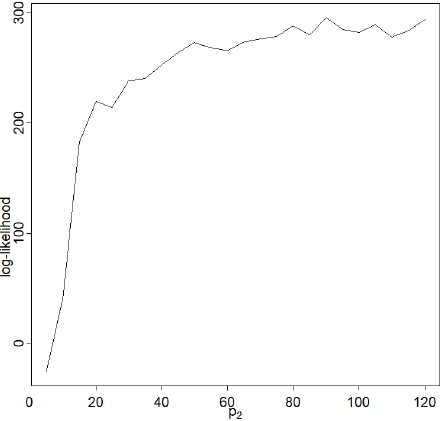
Figure 2. Log-likelihood function averaged over fifty independent simulations at each value of p 2